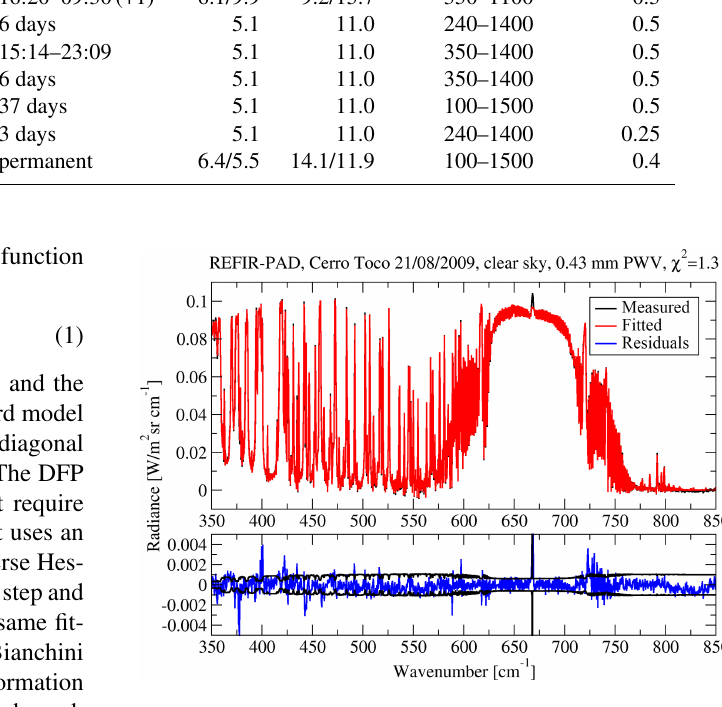
Figure 14. A typical result of the level 2 data analysis process. A single REFIR-PAD measurement is fitted using the LBLRTM for- ward model and the MINUIT minimization routines. Fitting residu- als are compared with the total radiometric uncertainty (black line) in the bottom